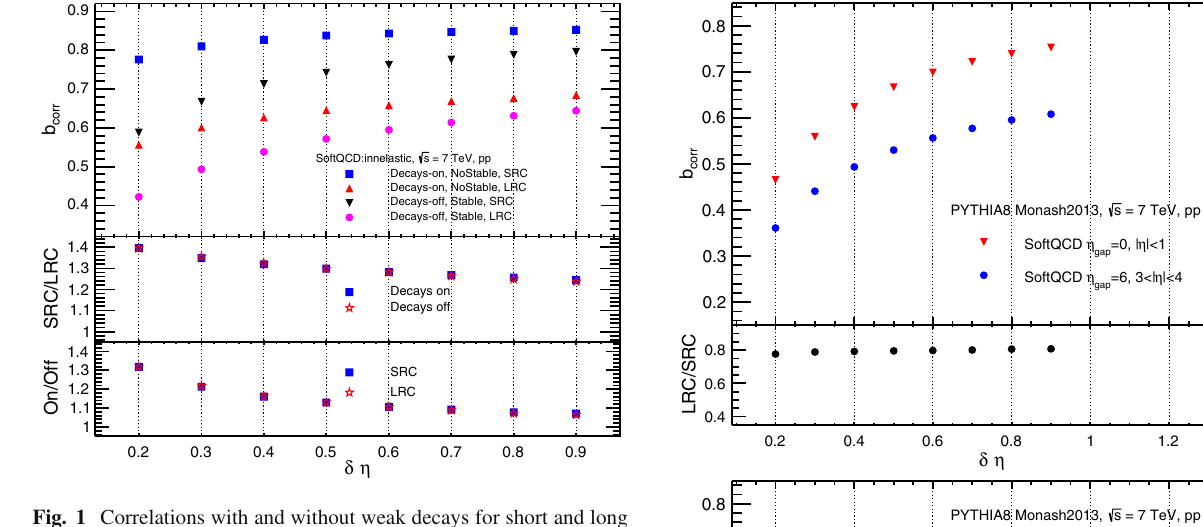
Fig. 2 Correlation factor for p + p collision at (upper)andhard(bottom)QCDprocesses,eachofthemshowingresults for central and fragmentation pseudorapidity regions. Each of the bot- tom panels show the ratio LRC to SRC strength correlations